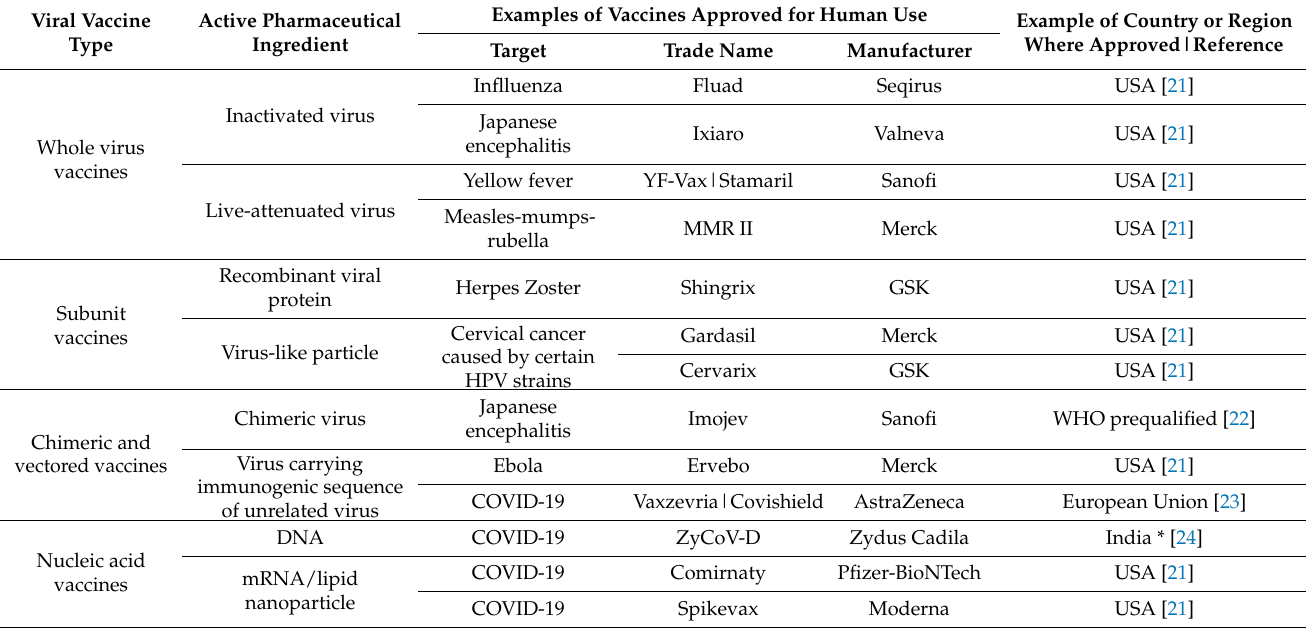
Table 1. Overview of types of vaccines that form the basis of approved viral